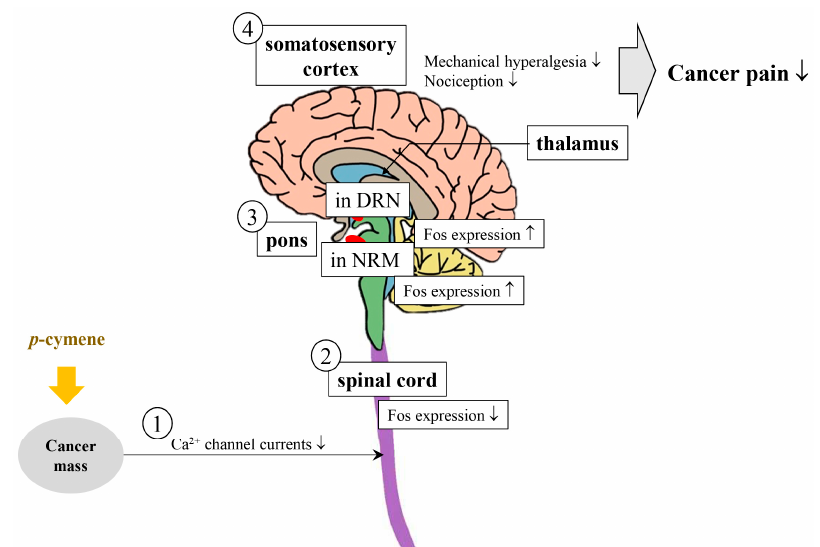
Figure 5. Mode of action of p -cymene for the reduction in cancer-associated pain via Ca 2+ channel current downregulation, modulation of Fos expression in the spinal cord and pons, and attenuation of mechanical hyperalgesia and nociception in the somatosensory cortex (modified from Santos et al. 2019 [75]). When p -cymene is subcutaneously administered, 1 (cid:13) there is a decrease in Ca 2+ channel currents and 2 (cid:13) the level of Fos expression decreases in the spinal cord. However, 3 (cid:13) Fos expression in the pons, particularly in the nucleus raphe magnus (NRM) and in the periaqueductal gray (PAG), decreases, thus resulting in 4 (cid:13) a decrease in both mechanical hyperalgesia and nociception through the somatosensory cortex, thus attenuating cancer-associated pain. ↑ : increasing; ↓ :